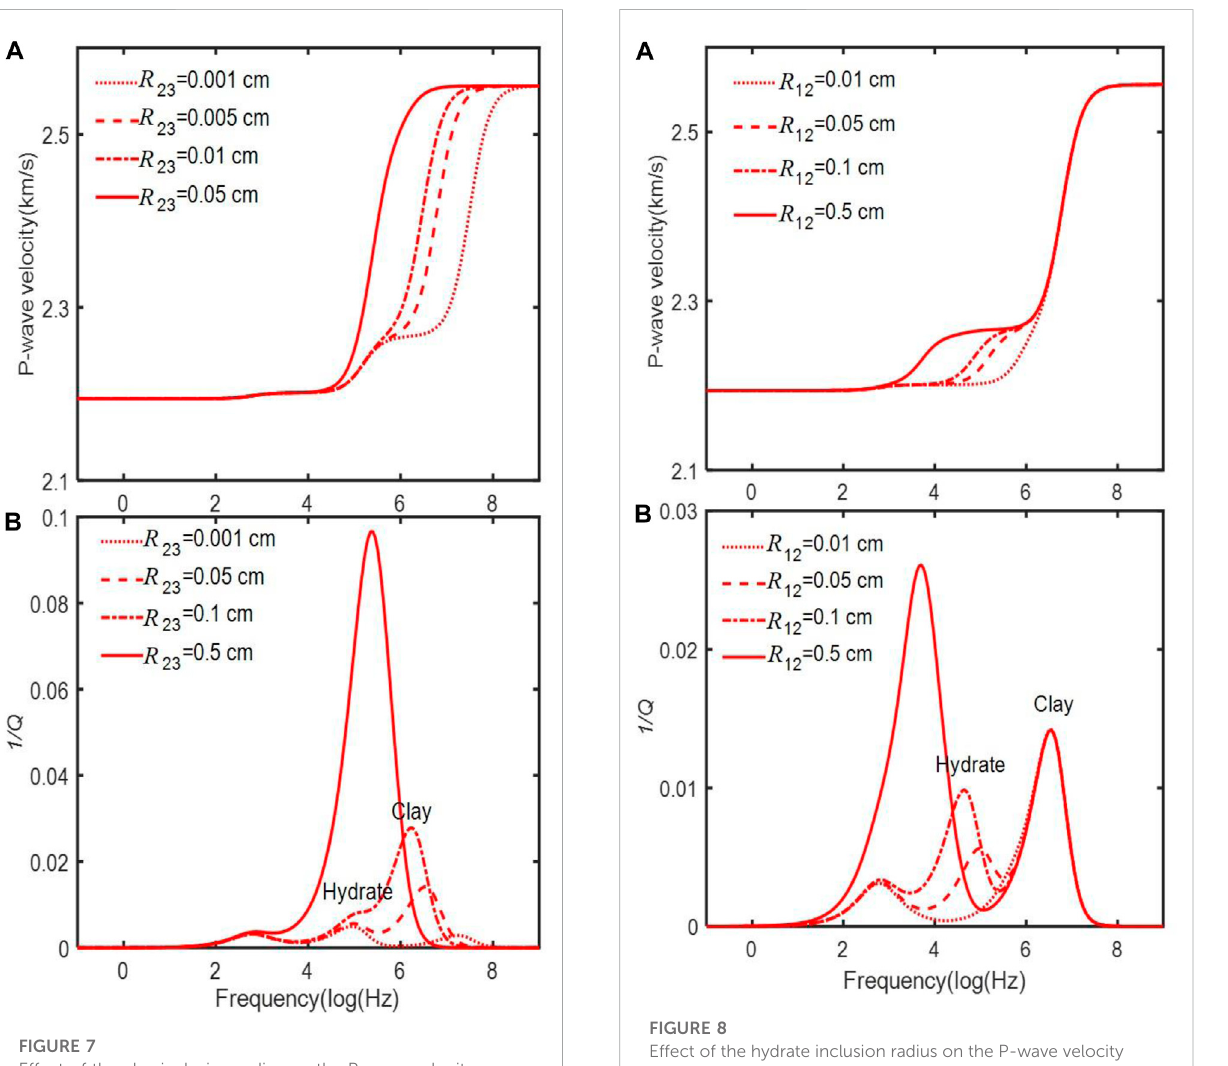
Effect of the clay inclusion radius on the P-wave velocity dispersion (A) and attenuation (B) . The radius of the hydrate inclusion is R 12 = 0.05 cm, and the rock porosity is ϕ = 20%.